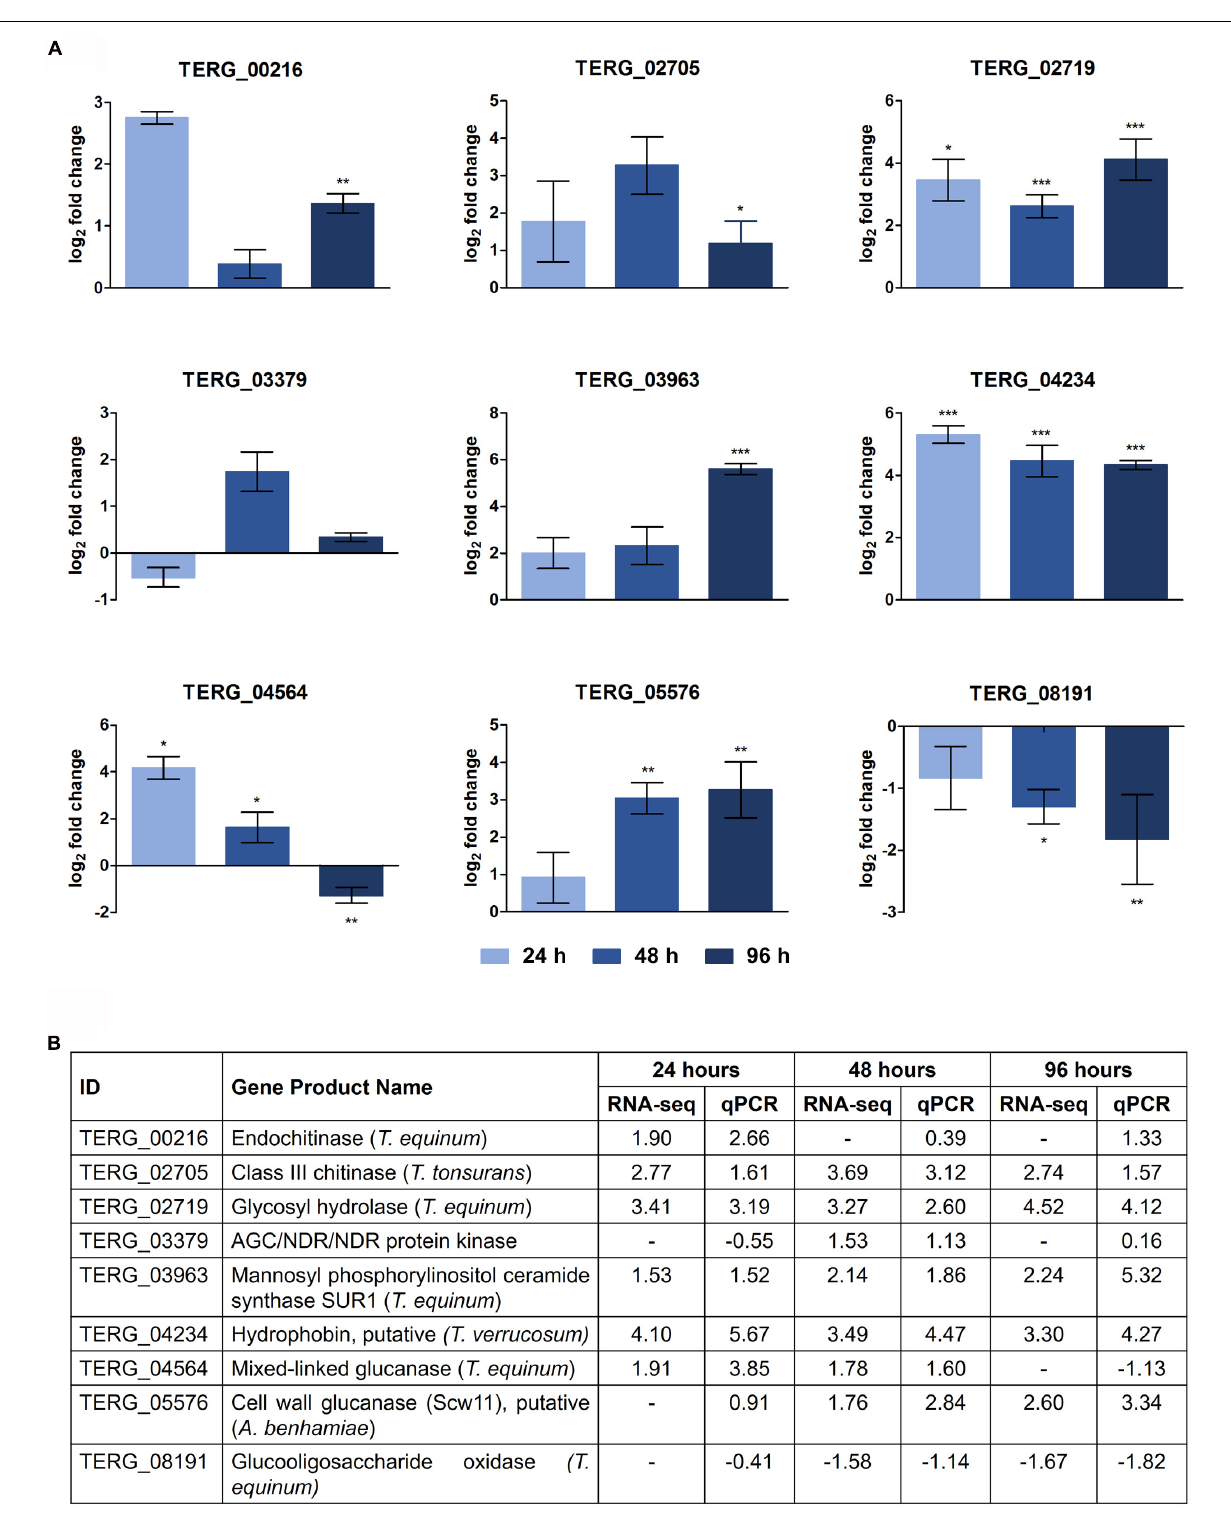
Frontiers in Microbiology |